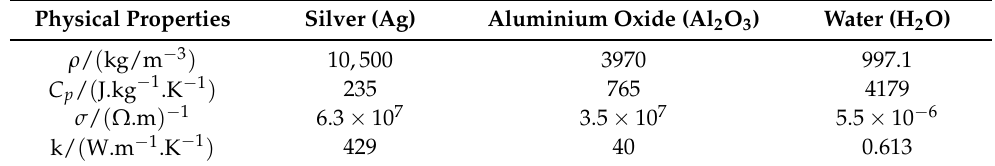
Table 1. The thermo-physical properties of the nanomaterials and water, see Roja and Gireesha [56].